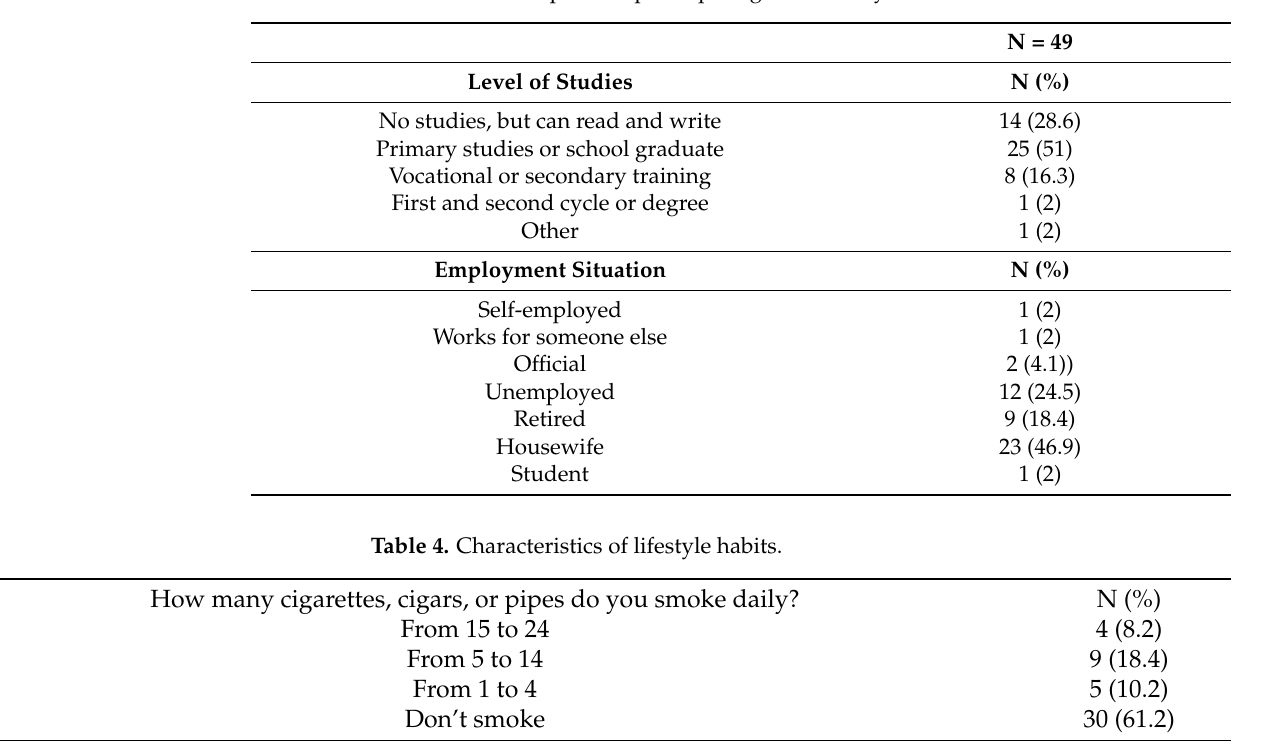
Table 3. Characteristics of the patients participating in the study.